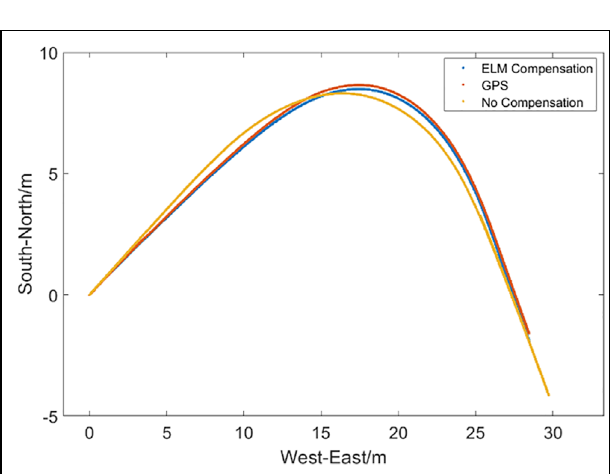
FIGURE 5 | Comparison result of the dead reckoning test under right-angle bending